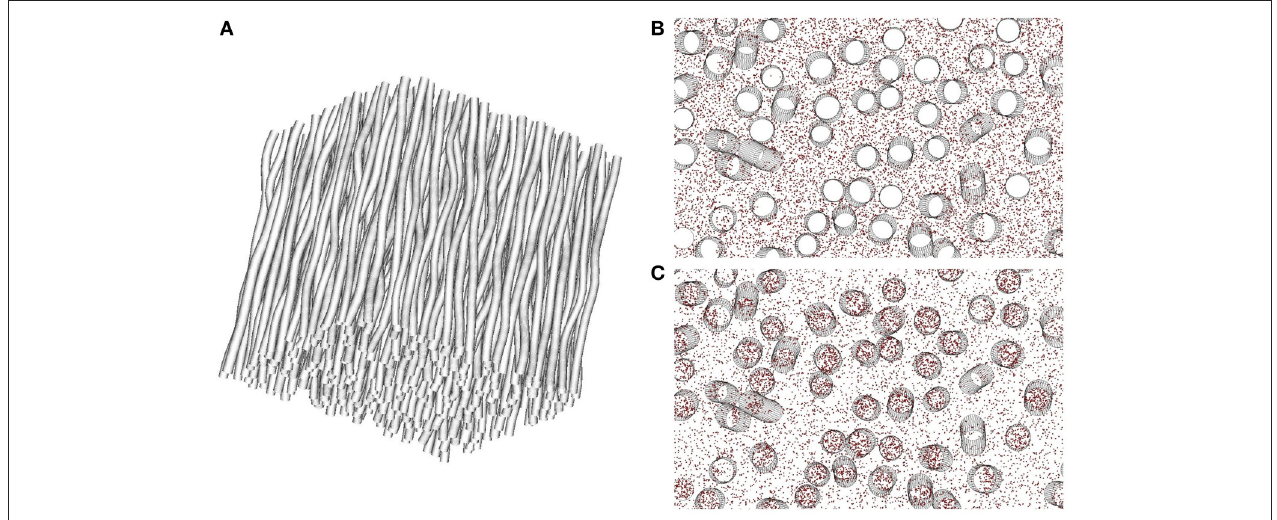
FIGURE 3 | Illustration of the two simulation modalities available in DMS on an example mesh (A) with intracellular volume fraction of 0.2 and 5 ◦ angular dispersion induced by tortuosity. In (B) corresponding to a cross-section of (A) , random walkers for Monte-Carlo simulation of the diffusion process are placed only in the extra-axonal space, with impermeable membranes. The obtained signal thus stems exclusively from the extracellular space. In (C) , particles are initially placed in both intra- and extra-cellular compartments, with impermeable membranes. The diffusion process is thus simulated in both compartments, without exchange between them.